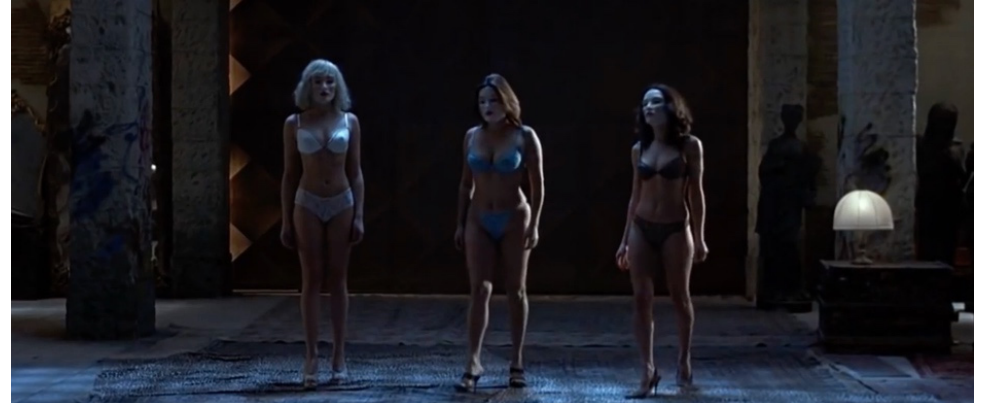
Figure 7. Opening scene from La sconosciuta ( The Unknown Woman , 2006) directed by Giuseppe Tornatore.